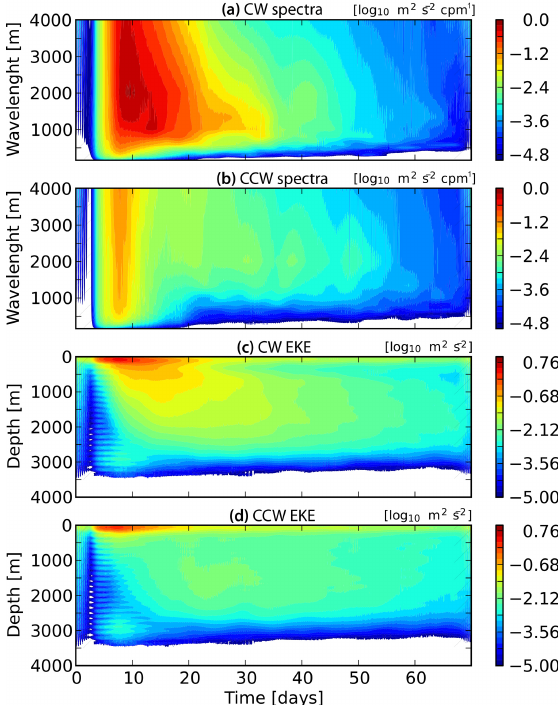
Figure 9. Temporal evolution of clockwise (CW) and counter- clockwise (CCW) spectra as a function of vertical wavelength, com- puted from Wentzel–Kramers–Brillouin (WKB)-stretched near- inertial velocities (a, b) for the single-storm experiment. Units are m 2 s − 2 cpm − 1 . Near-inertial KE computed as a function of time and depth from CW- and CCW-stretched velocities are shown in (c) and (d) . Units are m 2 s − 2 .